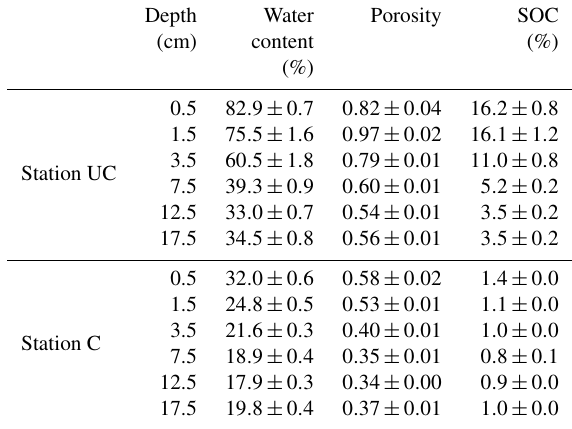
Table 1. Mean values of water content, porosity and soil organic carbon (SOC) for all core sectionings. Error indicated as SEM ( n =